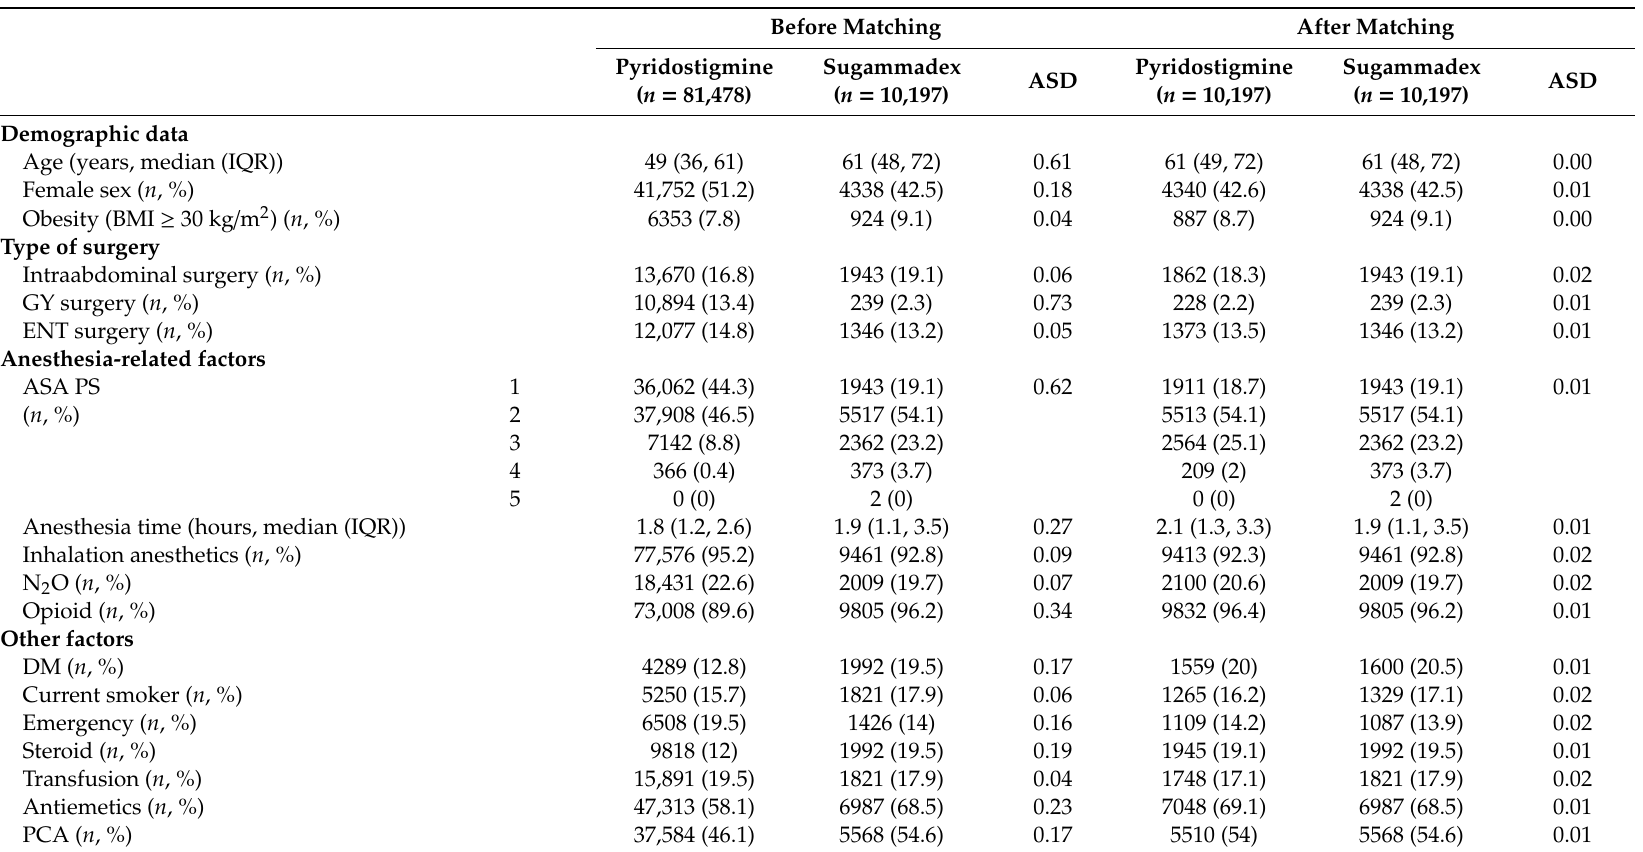
Table 2. Baseline patient characteristics and clinical data before and after matching: comparison between the pyridostigmine and sugammadex groups. Before Matching After Matching Pyridostigmine ( n =